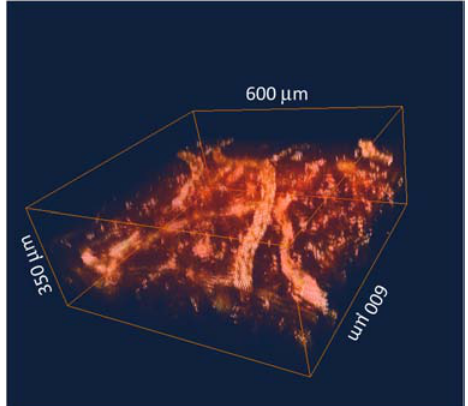
Fig. 4. 3D Reconstruction of the vasculature in the lamina propria of an excised section of mouse colon to a 350 (cid:1) m imaging